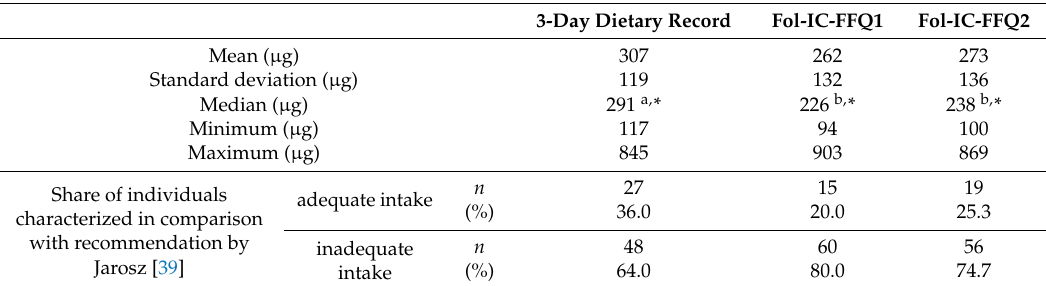
Table 3. The folate intake calculated using 3 ‐ day dietary record and Fol ‐ IC ‐ FFQ, accompanied by share of individuals characterized by adequate or inadequate intake.